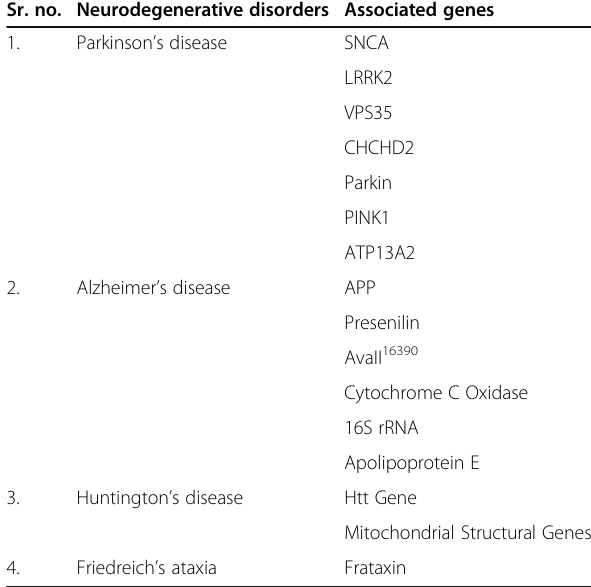
Table 1 Neurodegenerative disorders associated genes Sr. no. Neurodegenerative disorders Associated